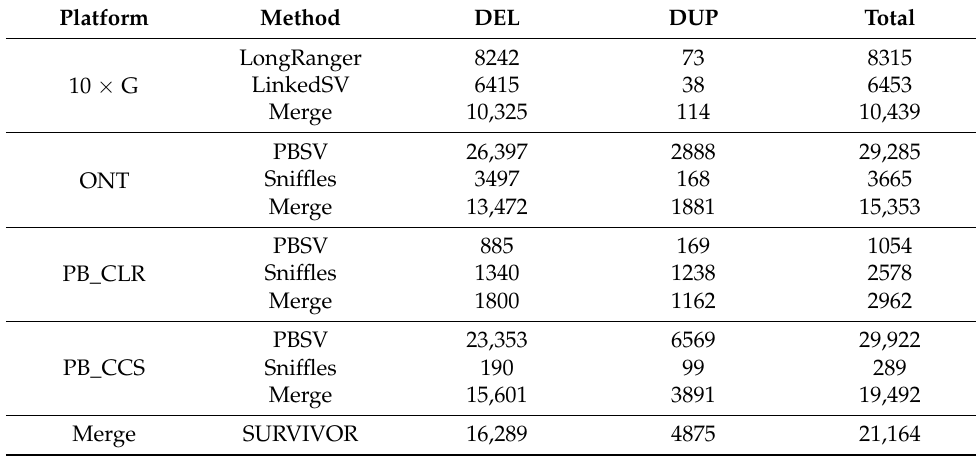
Table 2. Statistics over SVs identified by various